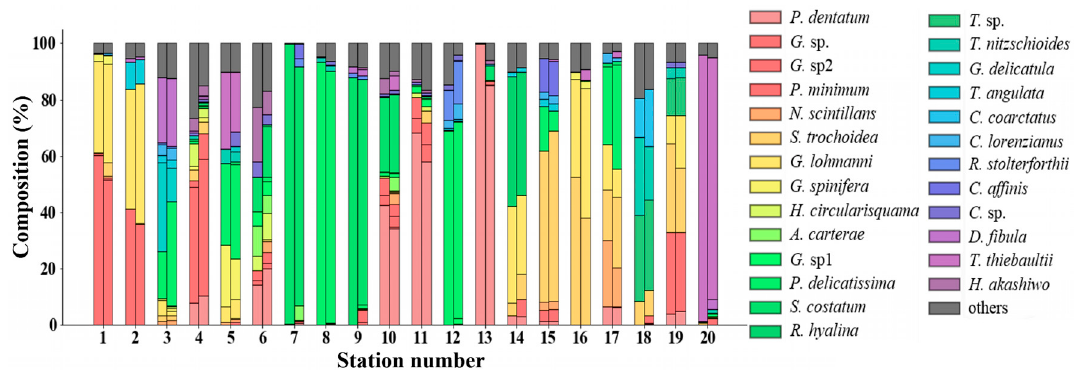
Figure 6. The phytoplankton species compositions of 20 stations in the validation dataset (Section 2.1). Each station has two stacked bars, with in situ measurements on the left and NN TL -predicted results on the right; the station numbers correspond to validation stations in Figure 1.